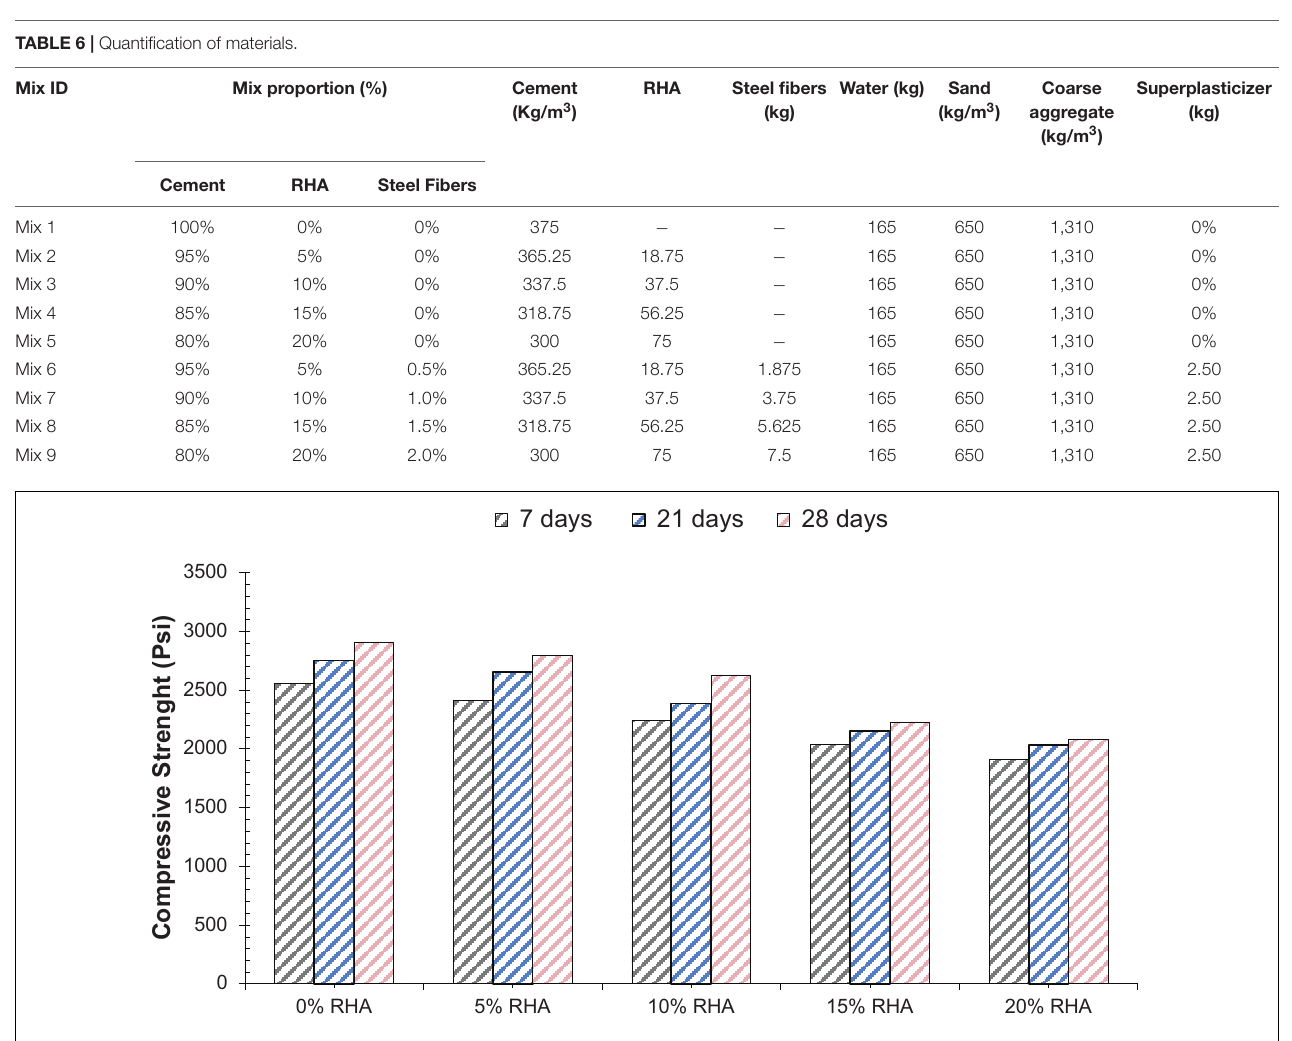
FIGURE 2 | Compressive strength (without steel fibers and